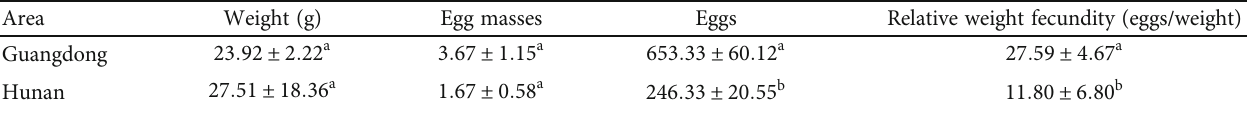
Table 2: Relative fecundity of Pomacea canaliculata in Guangdong and Hunan.